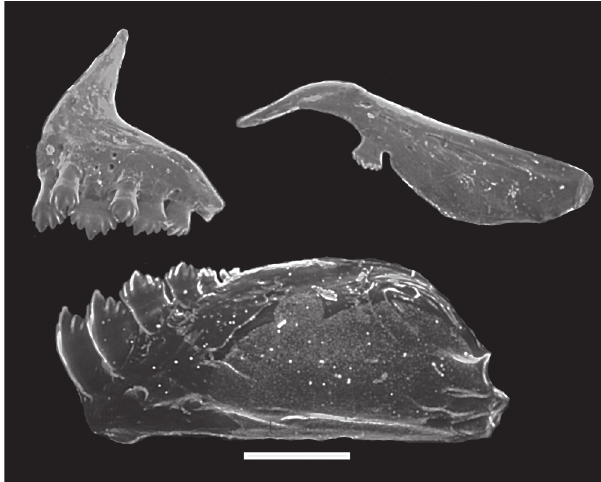
Fig. 2. Astyanax dissensus , new species, MCP 19561, 42.6 mm SL, paratype, upper and lower jaws teeth, left side, lateral view. Scale bar = 1 mm.